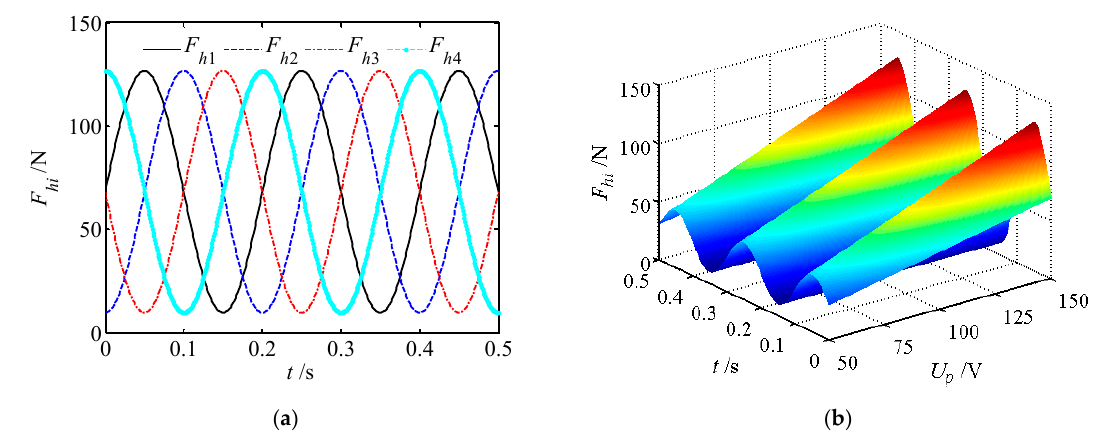
Figure 9. Harmonic force of the wave generator. ( a ) Harmonic under different input signals; ( b ) harmonic force varies with input voltage and time.